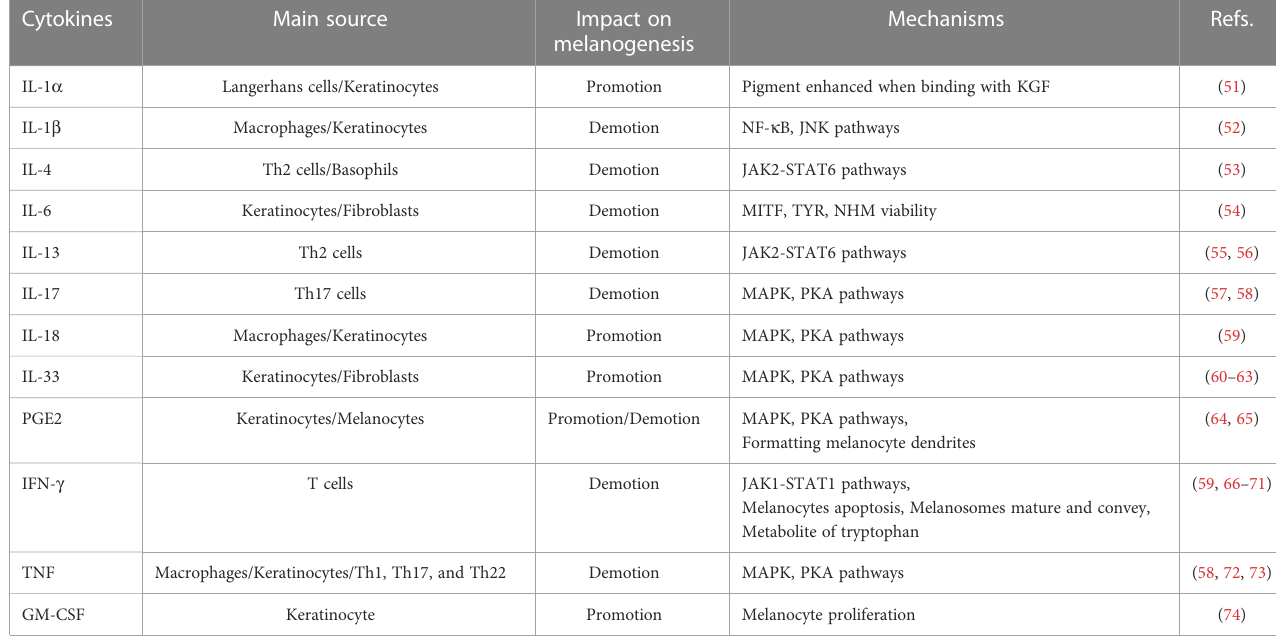
TABLE 1 The in fl uence of in fl ammatory cytokines on melanogenesis and its mechanisms. Cytokines Main